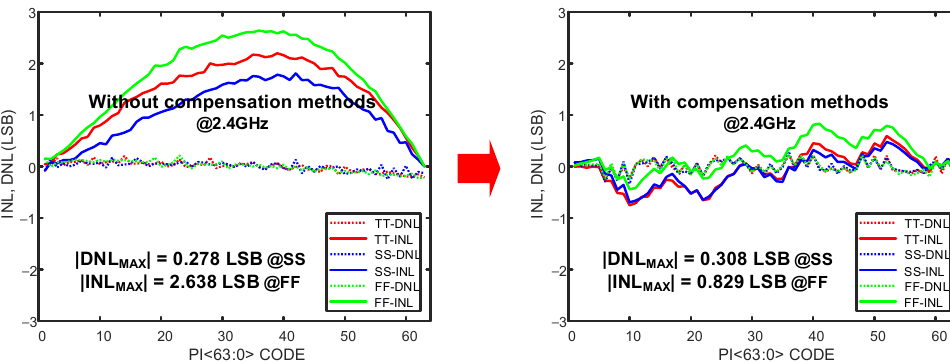
Figure 8. Post-layout corner simulation results of the proposed digital PI showing the INL and DNL